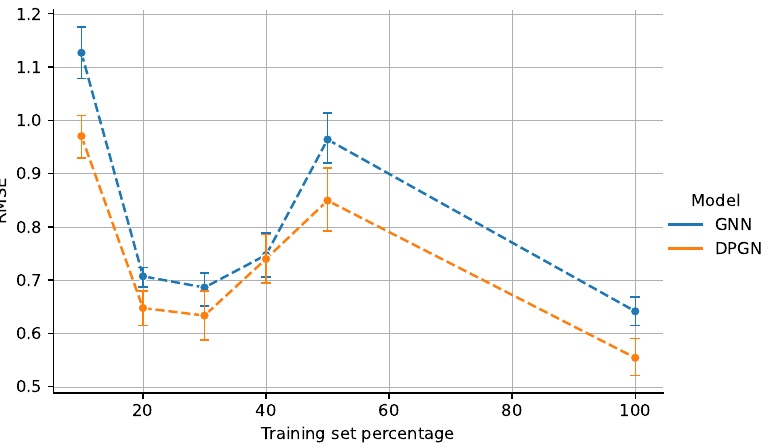
Figure 4. Climate prediction, RMSE of the models varying the training set